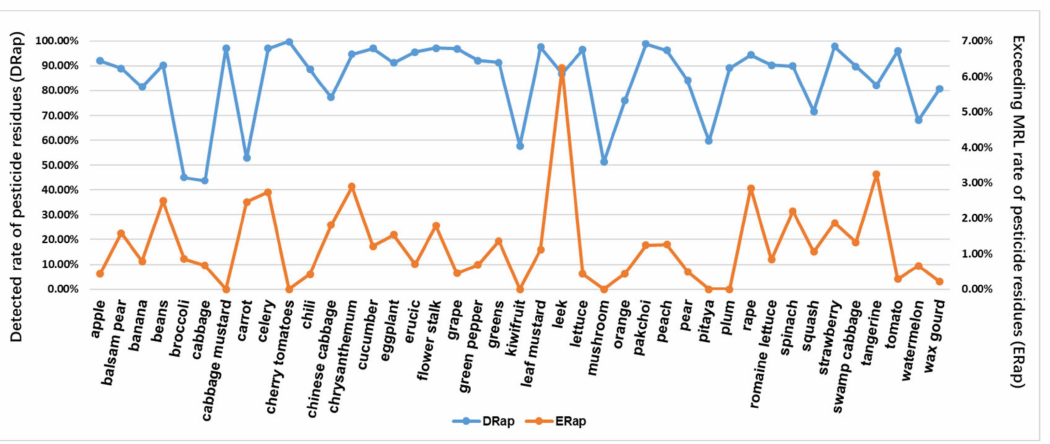
Figure 5. Detected rate of pesticide residues ( DR ap ) and exceeding MRL rate of pesticide residue ( ER ap ) in each agricultural